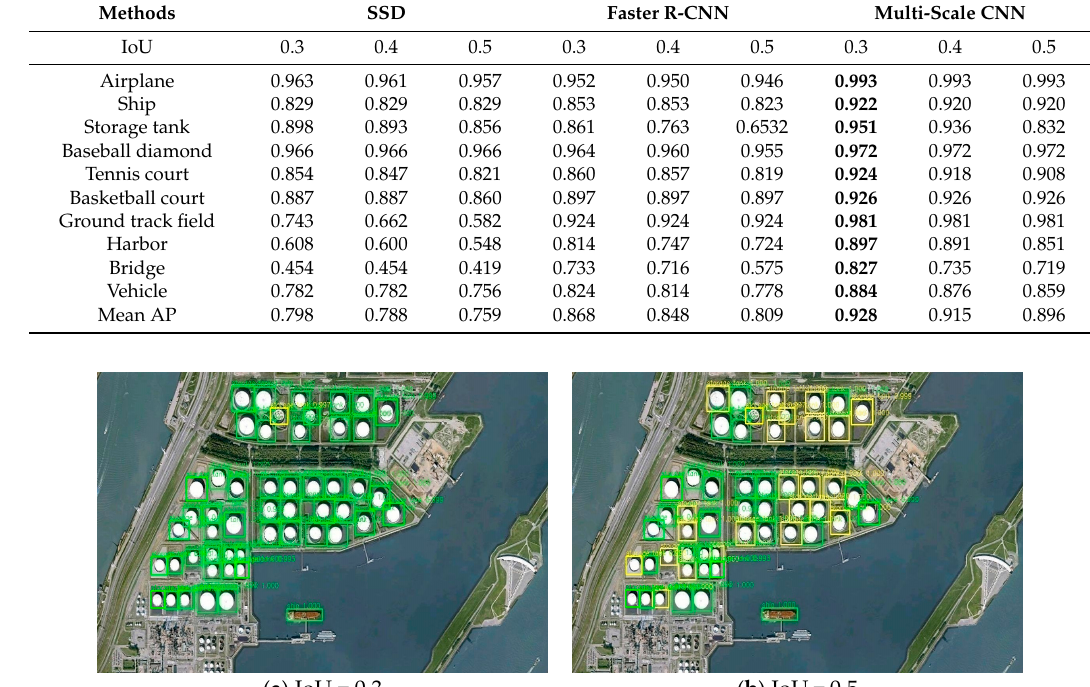
Table 6. The AP values of the three object detection methods under different IoU.